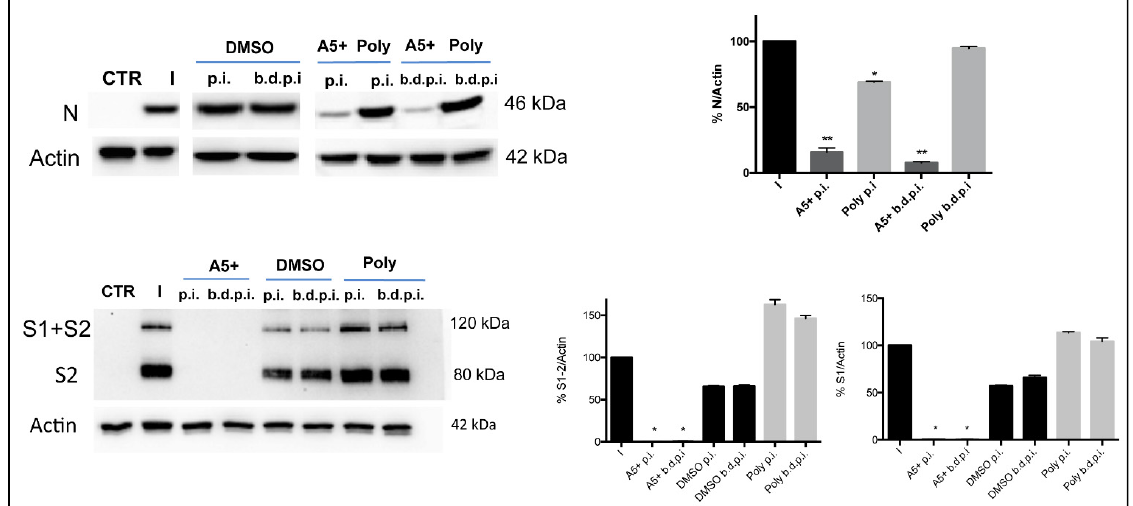
Figure 5. A5+ compound decreases SARS-CoV-2 proteins expression. Western blot analysis of Nucleocapsid (N) or Spike (S) proteins expression in Vero E6 cells infected with 0.1 MOI of SARS-CoV-2 and treated with 40 µg/mL of Polydatin (Poly) or A5+ for 24 h post infection (p.i.) or before, during and post infection (b.d.p.i.). DMSO was used at the same conditions in infected cells (I). Mock-infected cells were used as control of infection (CTR). Actin was used as loading control. Blot is one representative of two performed, obtained from independent experiments. The graphs represent the densitometry analysis of N or S protein expression normalized to actin and expressed as percentage (%) of treatment compared to infected cells (considered as 100%) (* p < 0.05 and ** p < 0.001 vs. I).